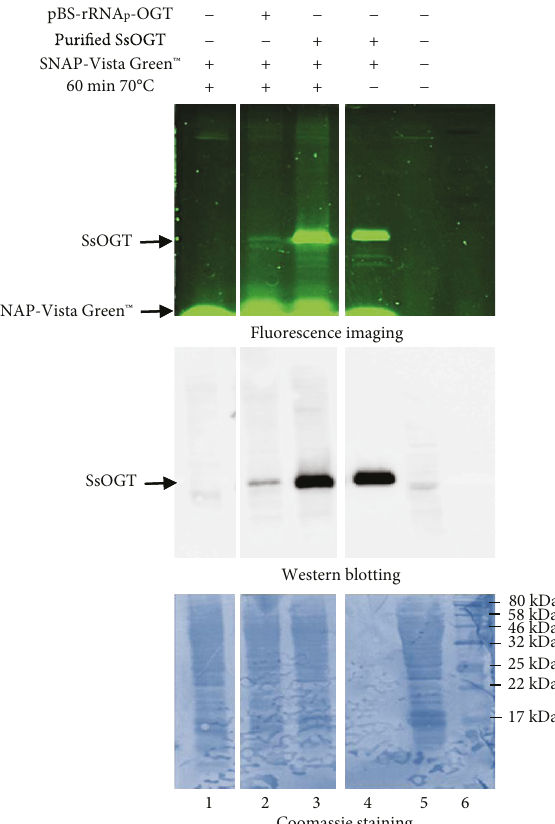
Figure 6: Ss OGT labeling. SDS-PAGE of in vitro-expressed pBS-rRNA - ogt plasmid and puri fi ed Ss OGT protein both p incubated with the BG-FL substrate (5 μ M) for 60min at 70 ° C. The gel was exposed for fl uorescence imaging analysis, blotted, and stained with Coomassie blue. The fi lter was probed with the anti-OGT antibody (middle panel). Lane 1 contains 100 μ g of S. solfataricus S30 fraction in the presence of the BG-FL substrate; lane 2 contains 8 μ g of pBS-rRNA - ogt plasmid in 100 μ g of p S. solfataricus S30 fraction and BG-FL substrate; lane 3 contains 200ng of puri fi ed OGT protein with 100 μ g of S. solfataricus S30 fraction and BG-FL substrate; lane 4 contains 200 ng of puri fi ed OGT protein with BG-FL substrate; lane 5 contains 100 μ g of S. solfataricus S30 fraction; and lane 6 corresponds to the protein